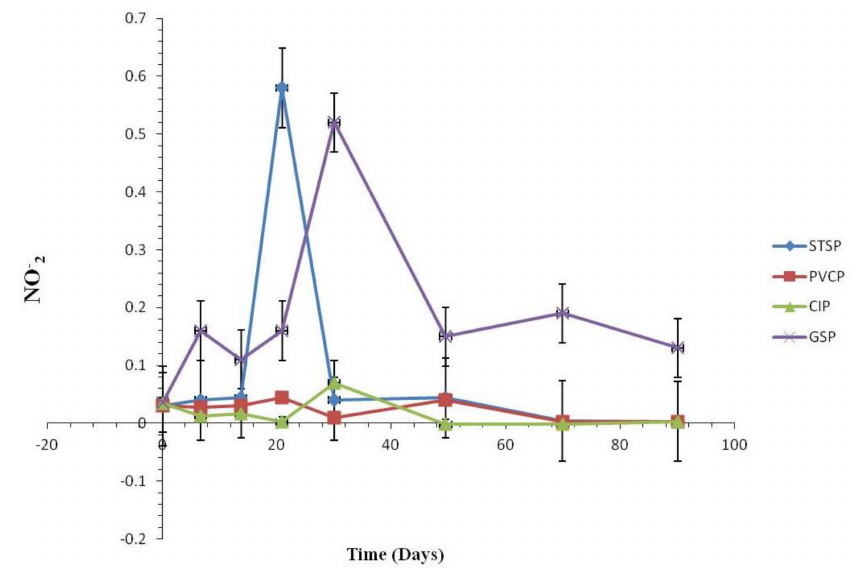
Figure 6. Variations of nitrite concentration in RW in stainless steel, polyvinyl chloride, cast iron, and galvanized steel pipes over time with standard error bars.